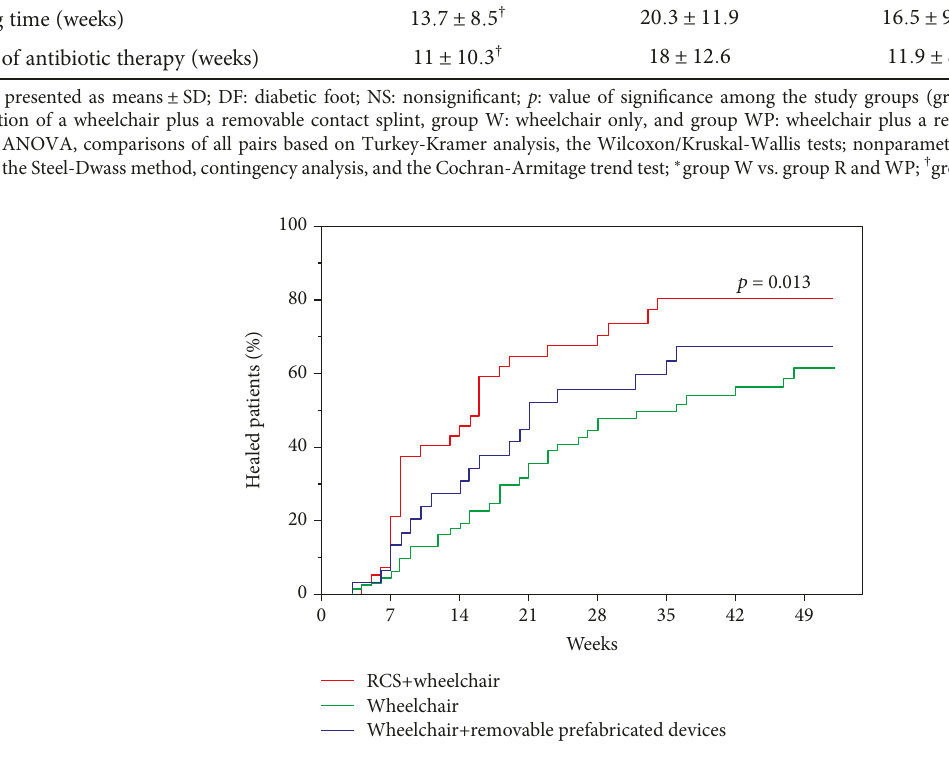
Figure 3: Healing of DF after surgical procedures using di ff erent o ff -loading devices. Table 3: A comparison of secondary outcomes of DF therapy after foot surgery among the study